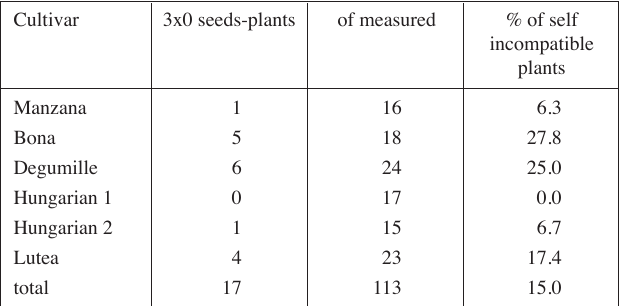
Tab. 1: Detected percentages of self-incompatibility in six chamomile varieties Cultivar